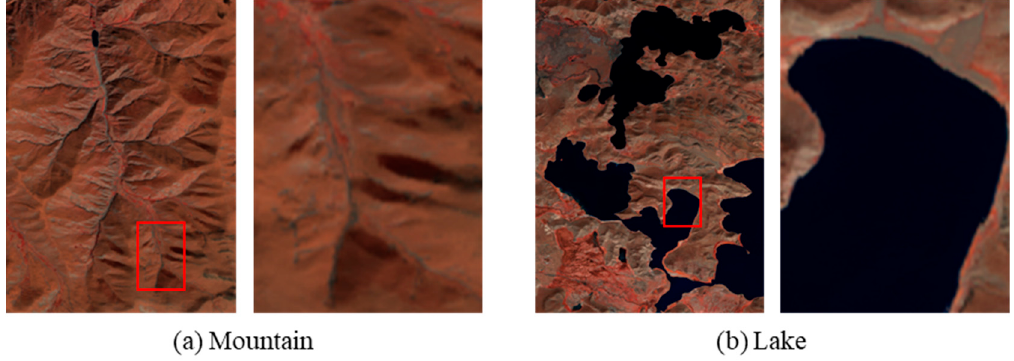
Figure 3. Examples of self-similar patterns inside a RS image.